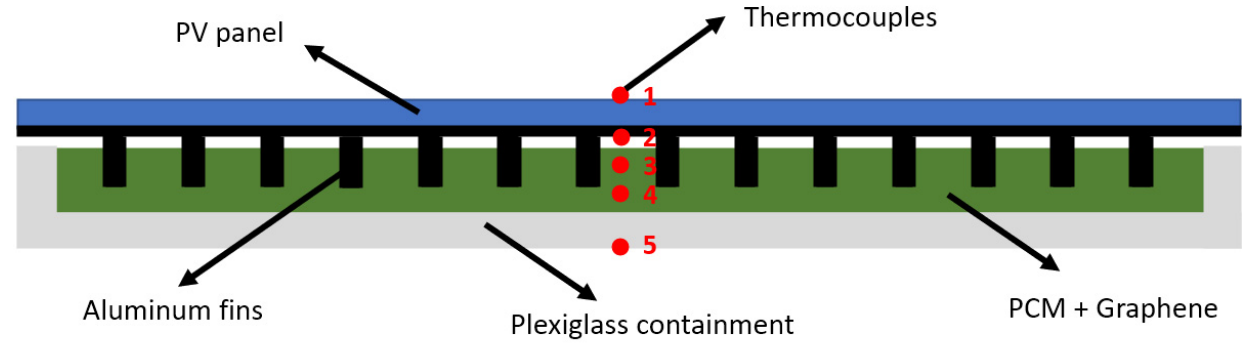
Figure 2. A schematic section of the proposed PV–PCM panel.